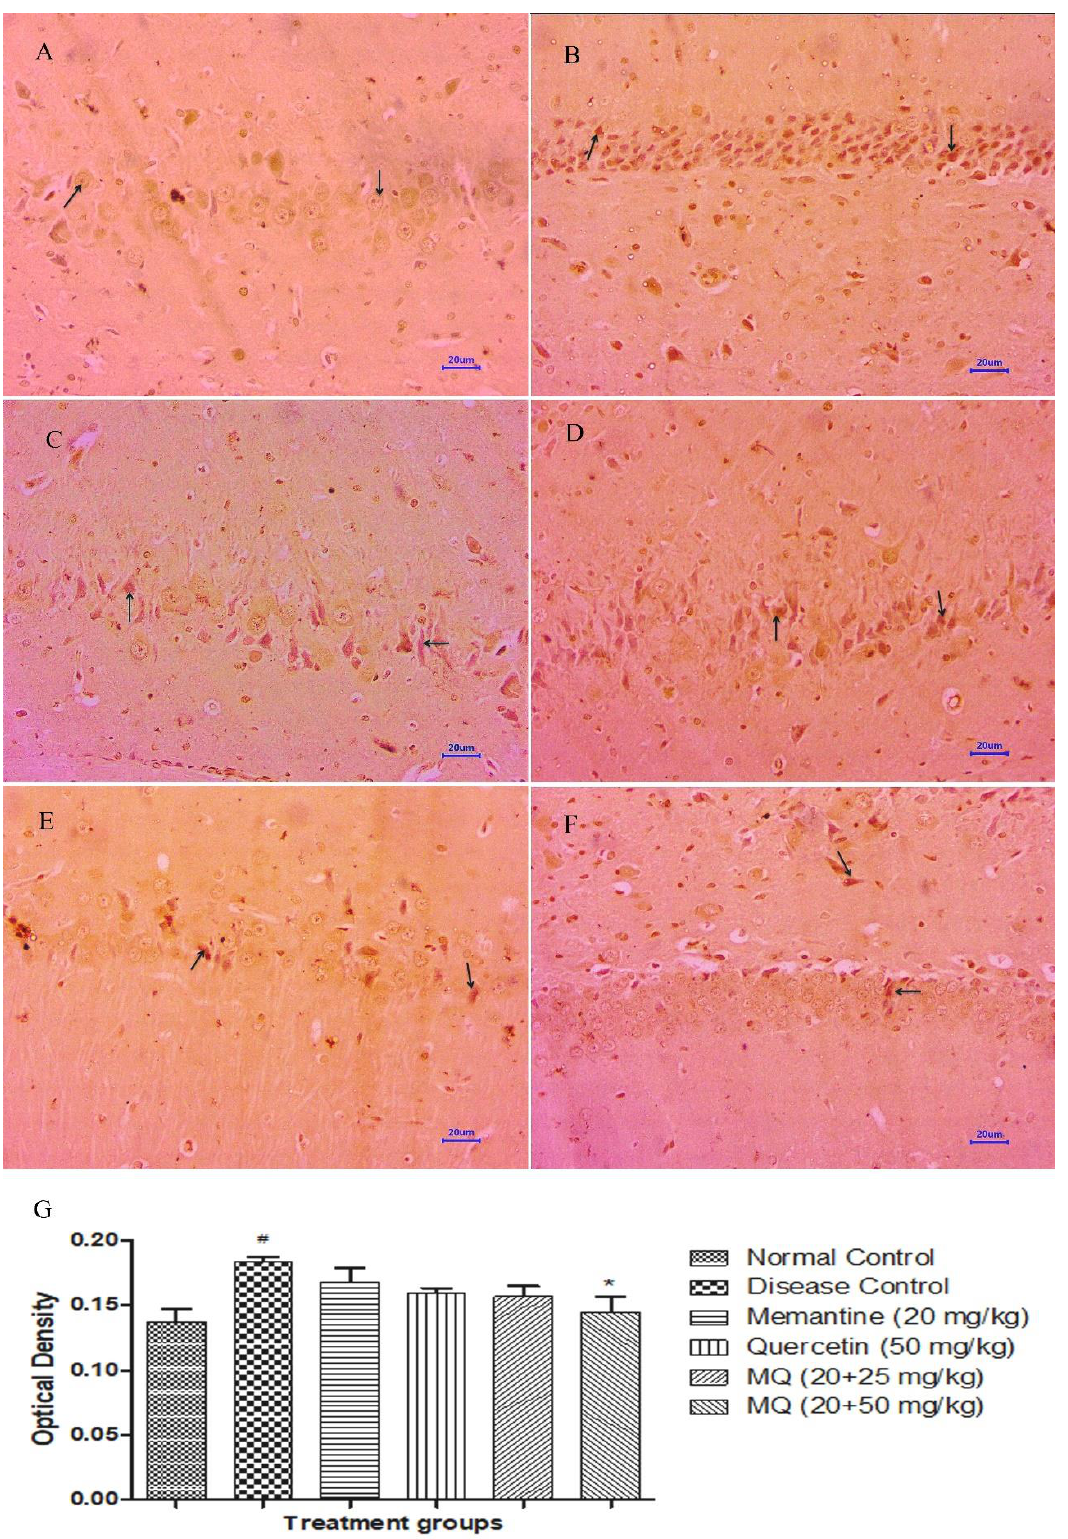
Figure 12. Effect of quercetin and quercetin administered with memantine on immuno-histochemical-stained hippocampus (400×). ( A ): Normal control, ( B ): Disease control, ( C ): Memantine (20 mg/kg), ( D ): Quercetin (50 mg/kg), ( E ): Memantine + quercetin (20 + 25 mg/kg), ( F ): Memantine + quercetin (20 + 50 mg/kg), ( G ): Optical density data. Data expressed as mean±SEM (n = 3), # p < 0.05 when compared with normal control group, * p < 0.05 when compared disease control group.